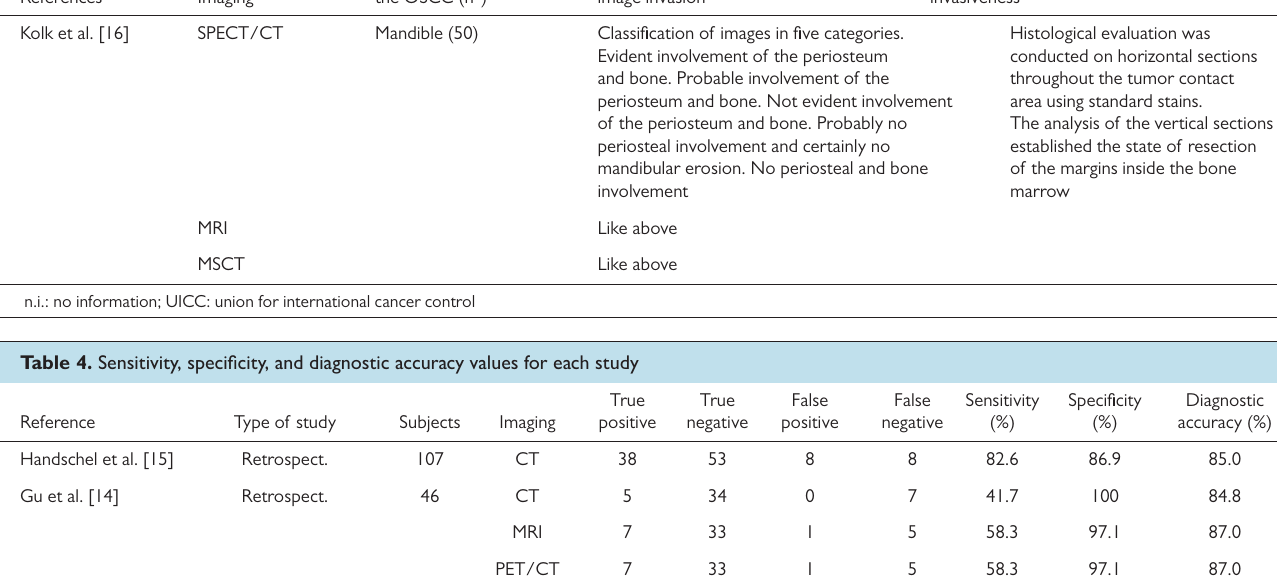
Table 3. Types of diagnostic imaging methods, site of the tumors, and invasiveness criteria for the imaging and histopathological findings Anatomical place of Diagnostic criteria